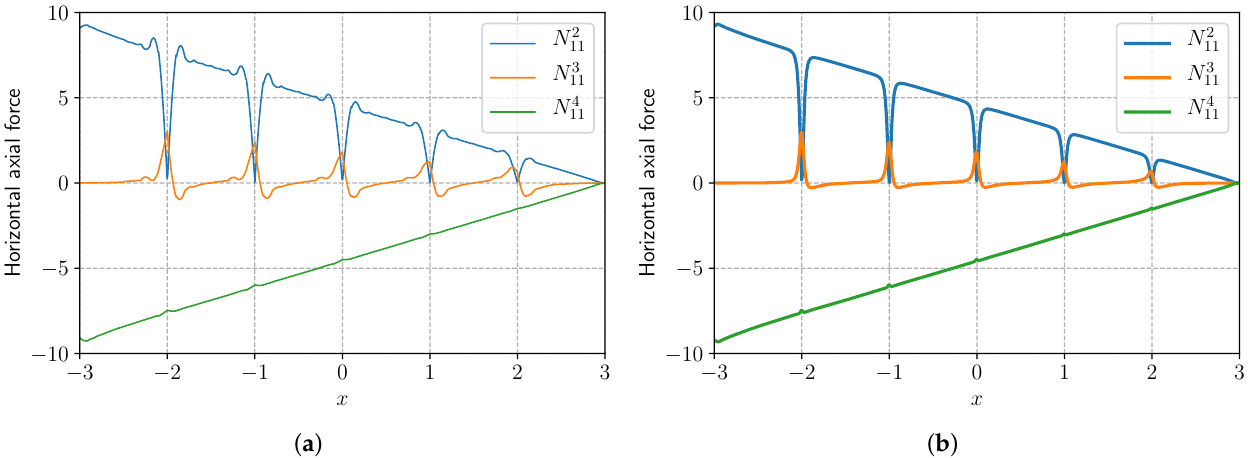
Figure 14. Axial force N 11 [MPa/m] along the plate length in layers 2, 3 and 4. ( a ) Coarse mesh; ( b ) fine mesh.